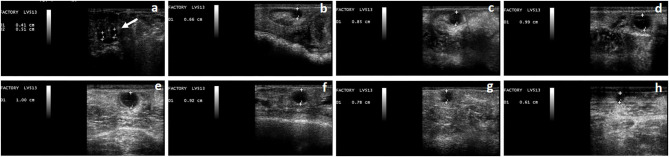
Phases of the follicular wave in a llama. The growth phase (a–d), plateau phase (d,e), regression phase (f–h), can be observed. At the beginning of the growth phase, the simultaneous growth of a group of follicles can be observed (a), one of which will become dominant (indicated by the arrow). Follicle's diameter is expressed in cm.